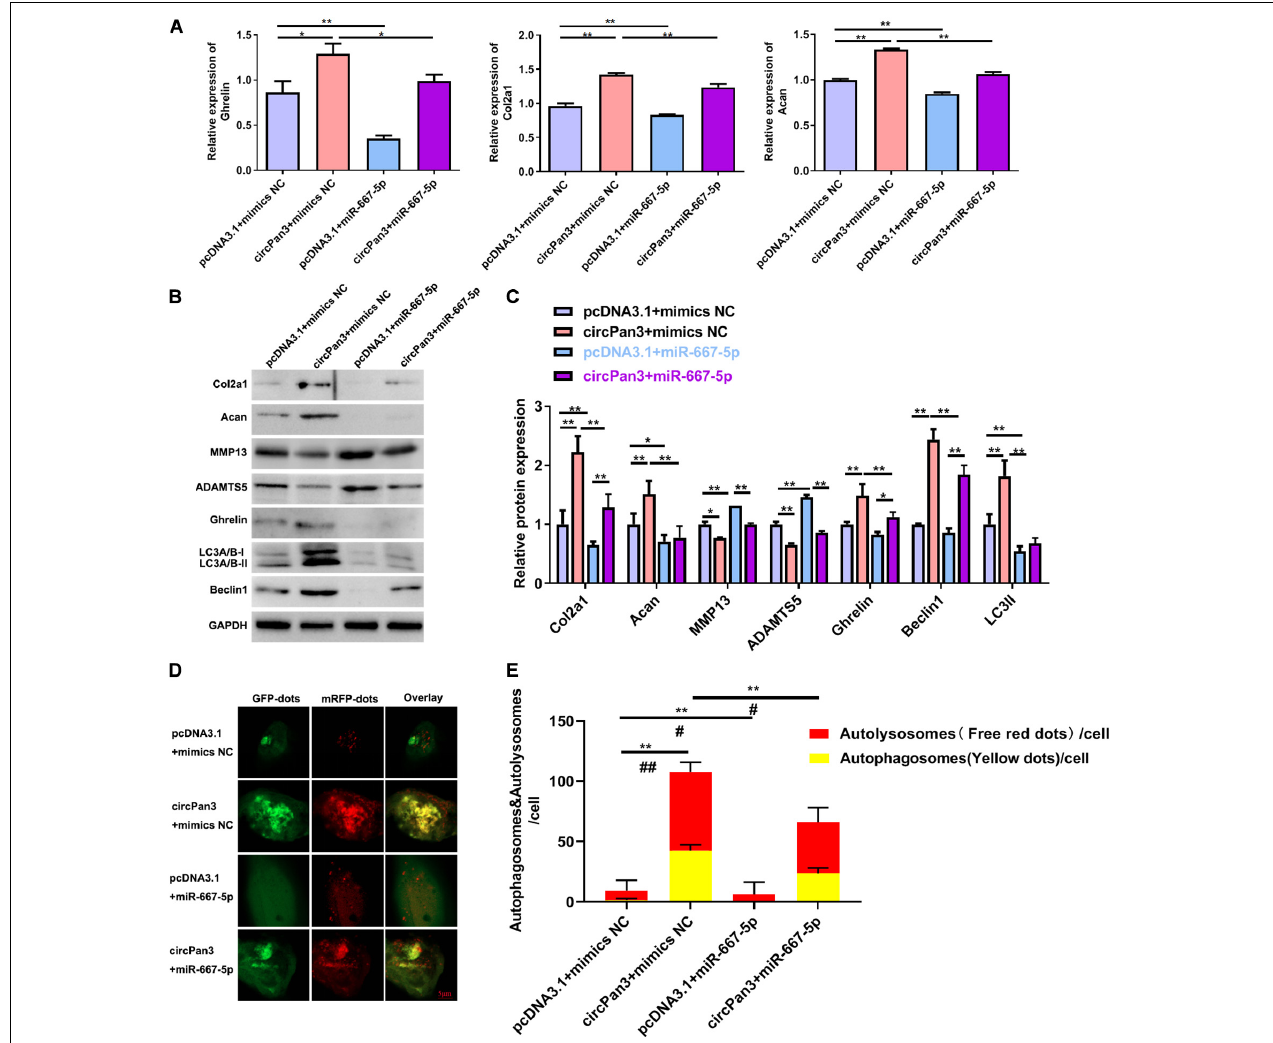
FIGURE 7 | The effects of miR-667-5p on the circPan3-regulated ghrelin synthesis, chondrocyte autophagy, and OA progression. (A) RT-qPCR results of ghrelin, Col2a1, and Acan gene expressions in rat chondrocytes treated as indicated. (B) Western blotting results of Col2a1, ghrelin, Acan, MMP13, ADAMTS5, beclin 1, and LC3 in rat chondrocytes treated as indicated. (C) Quantitative analysis results of western blotting in (B) . (D) Autophagy in rat chondrocytes was identified by confocal laser scanning microscope. Yellow fluorescence represents autophagosomes and red fluorescence represents autolysosomes, respectively. (E) The average number of yellow dots (autophagosomes) and red dots (autolysosomes) per cell in each group was analyzed. mimics NC, mimics negative control; RT–qPCR, quantitative real-time polymerase chain reaction; Col2a1, collagen 2a1; Acan, aggrecan; MMP13, matrix metallopeptidase 13; ADAMTS5,